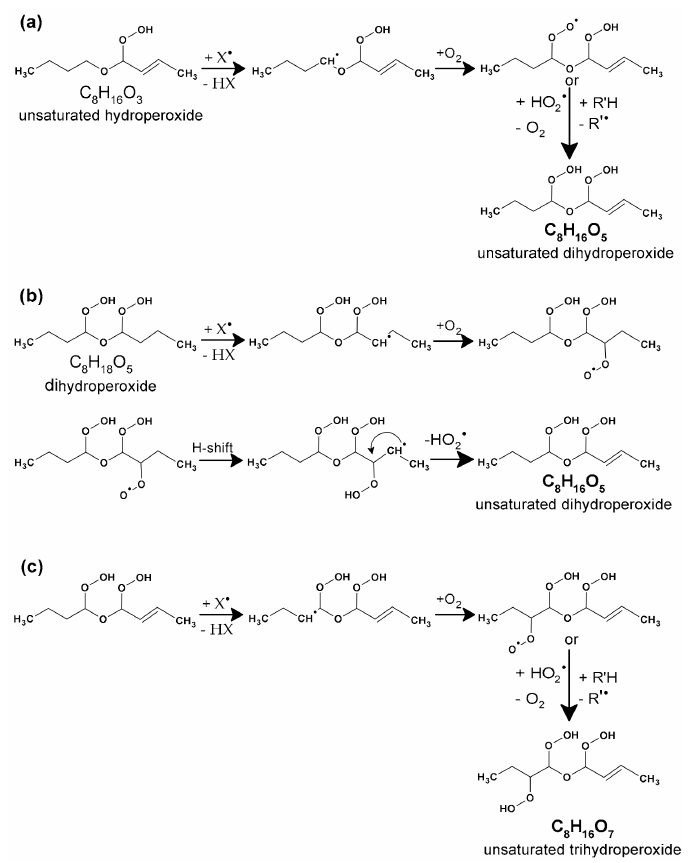
Scheme 3. Proposed formation routes for ( a , b ) unsaturated di-hydroperoxides (C 8 H 16 O 5 ) and ( c ) unsat- urated tri-hydroperoxides (C 8 H 16 O 7 ) during the low-temperature oxidation of di-n-butyl